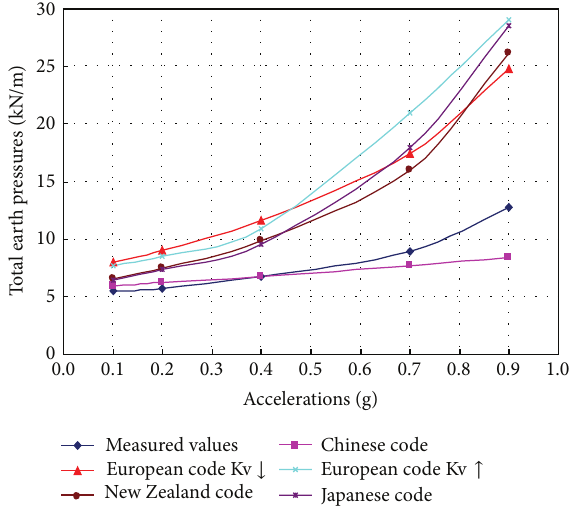
Figure 13: Comparison of measured earth pressures and theoretical results by codes for rock